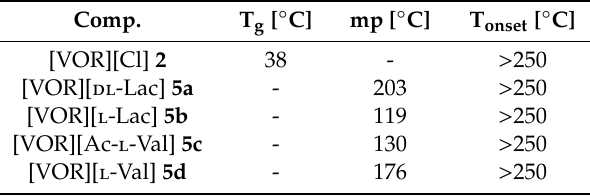
Table 1. Physicochemical properties of VOR salts. Comp.